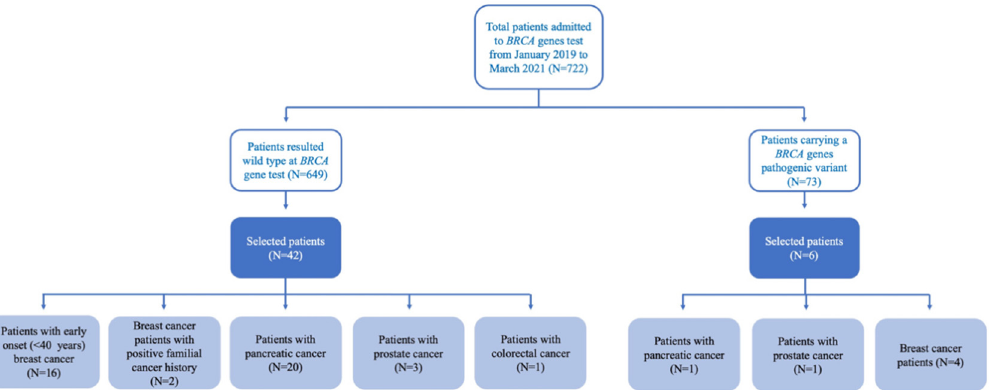
Figure 1. Strobe diagram representing the flow-chart of patient selection. In total, 48 samples were included in this study: 6 were carriers of a pathogenic variant in BRCA1/2 and were included as analytic controls; 42 patients were determined as wild type after the diagnostic genetic test showing different clinical phenotypes, and were included to verify the presence of pathogenic, cancer-risk variants in the newly tested genes (i.e., PALB2 and CHEK2 ).